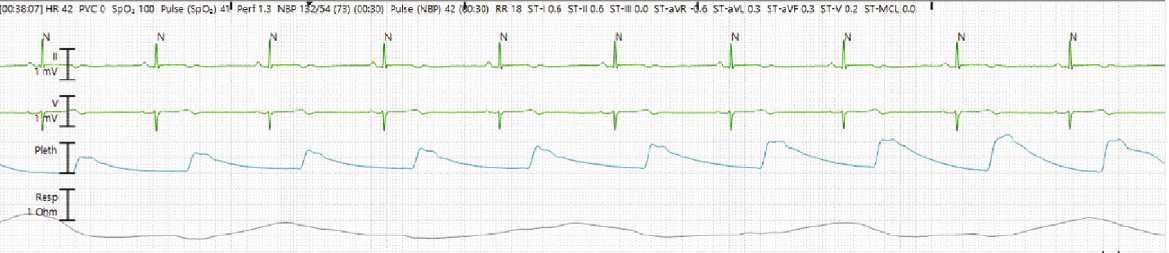
Figure 4: Telemetry strips showing bradycardia after the initiation of RDV (day